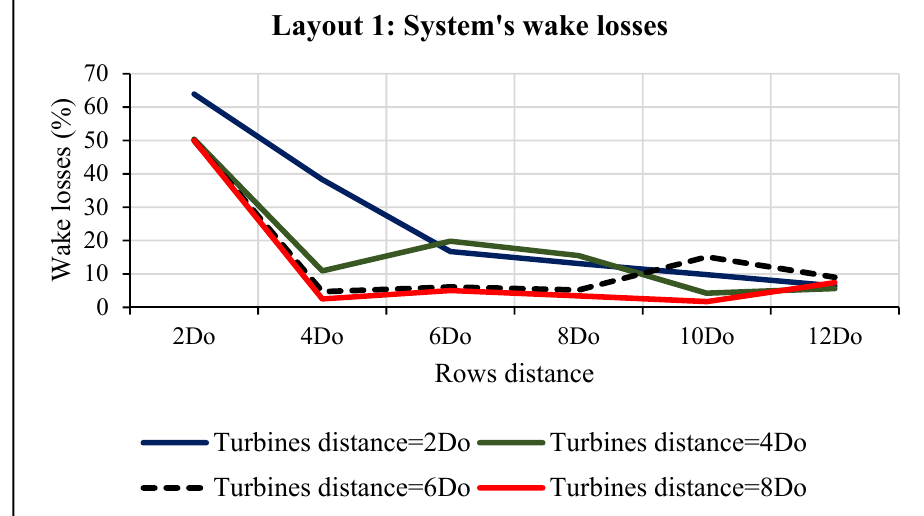
Figure 13. System’s wake losses for different distances between turbines and rows. For row spacing of 2D o and distance between turbines of 8D o , maximum wake loss is